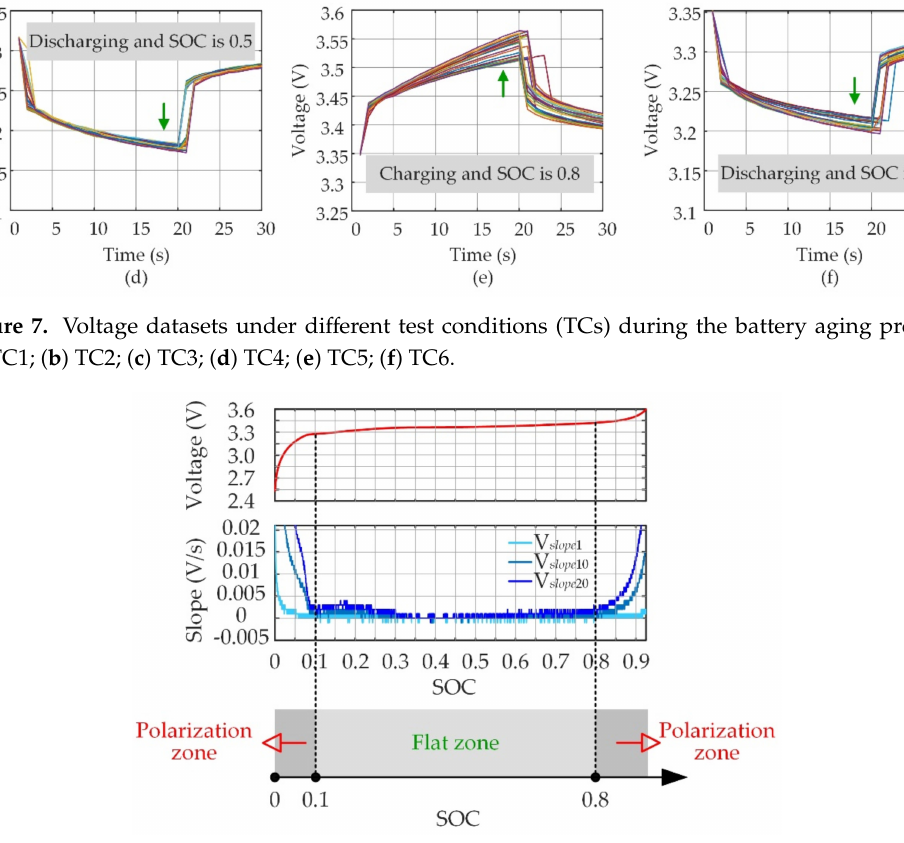
Figure 8. Terminal voltage and its slope curve under the 1C-rate constant current full charging